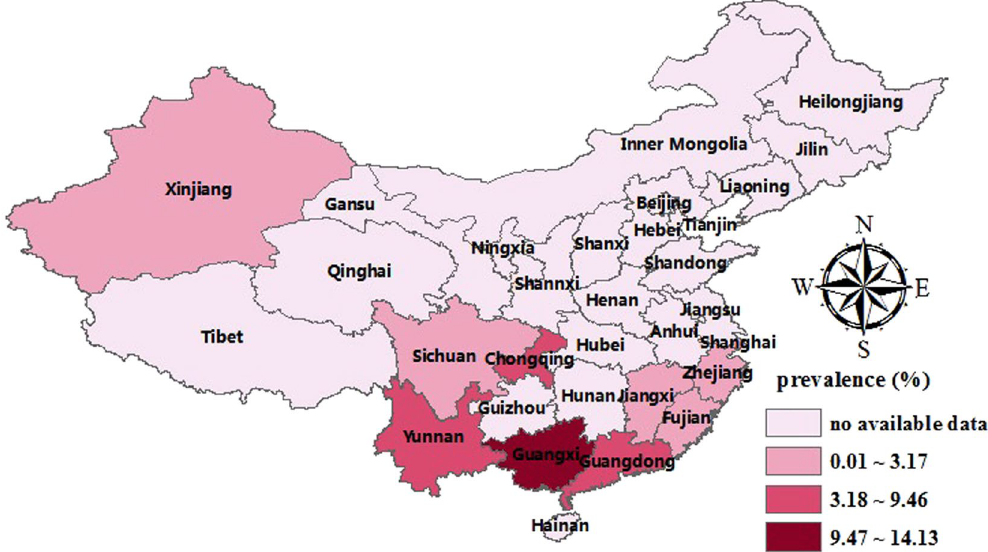
Figure 4. Distribution of the prevalence of α -thalassemia in different regions of mainland